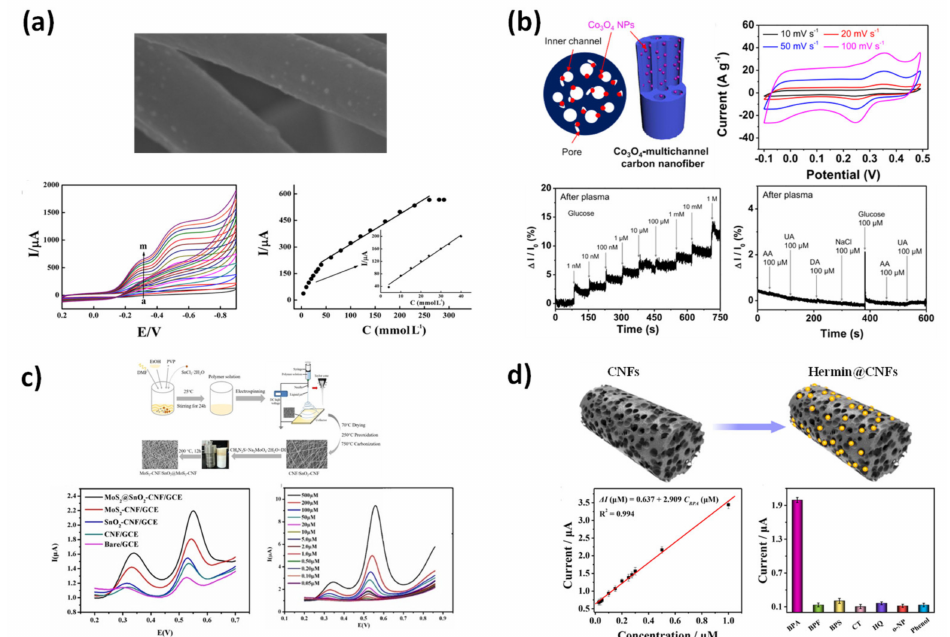
Figure 18. ( a ) Trichloroacetic acid (TCA), KBrO 3 , and NaNO 2 using Co 3 O 4 embedded CNFs [132]. ( b ) Multichannel CNFs decorated with Co 3 O 4 as a glucose sensor [133]. ( c ) CNFs modified using MoS 2 and embedded with SnO 2 for phenacetin/indomethacin detection [134]. ( d ) Porous CNFs with Fe 3+ for the detection of BPA